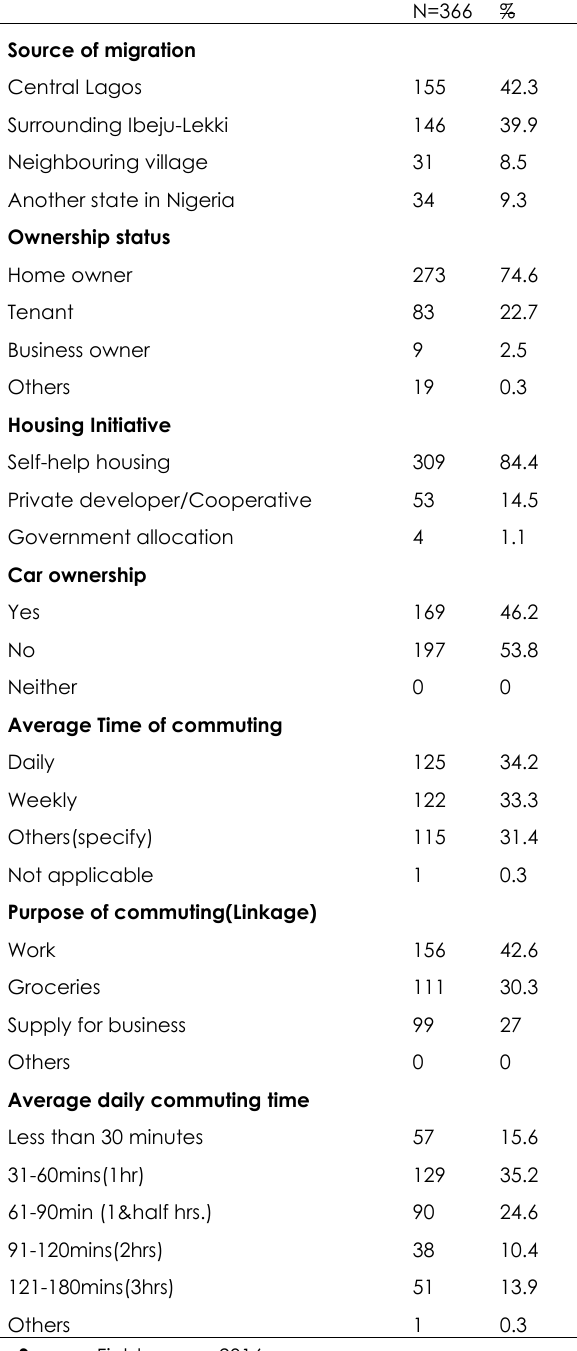
Table 4. Characteristics of migrants in the study